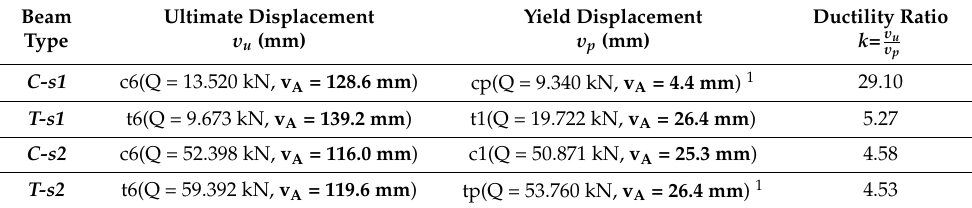
Table 3. Ductility ratio of beams.